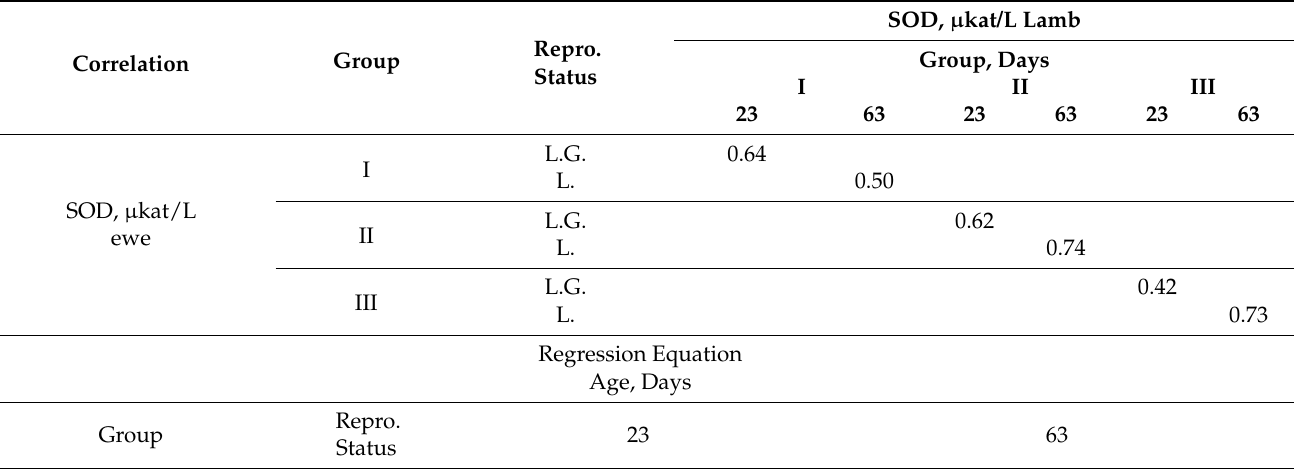
Table 7. Correlation coefficients and regression equations between activity of SOD in the blood of ewes and